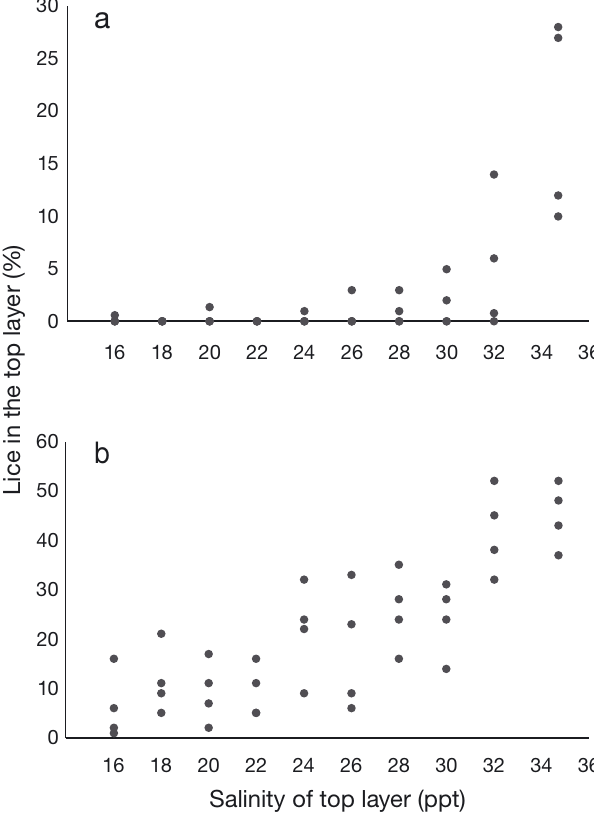
Fig. 2. Percentage of salmon lice (a) nauplii and (b) copepo- dids in the layer above the step salinity gradient as a function of the salinity in the overlying layer. Each point represents the proportion of lice in the top layer for a column replicate. The 34.7 ppt treatment served as an isohaline control (34.7 ppt in both the top and bottom layers of the